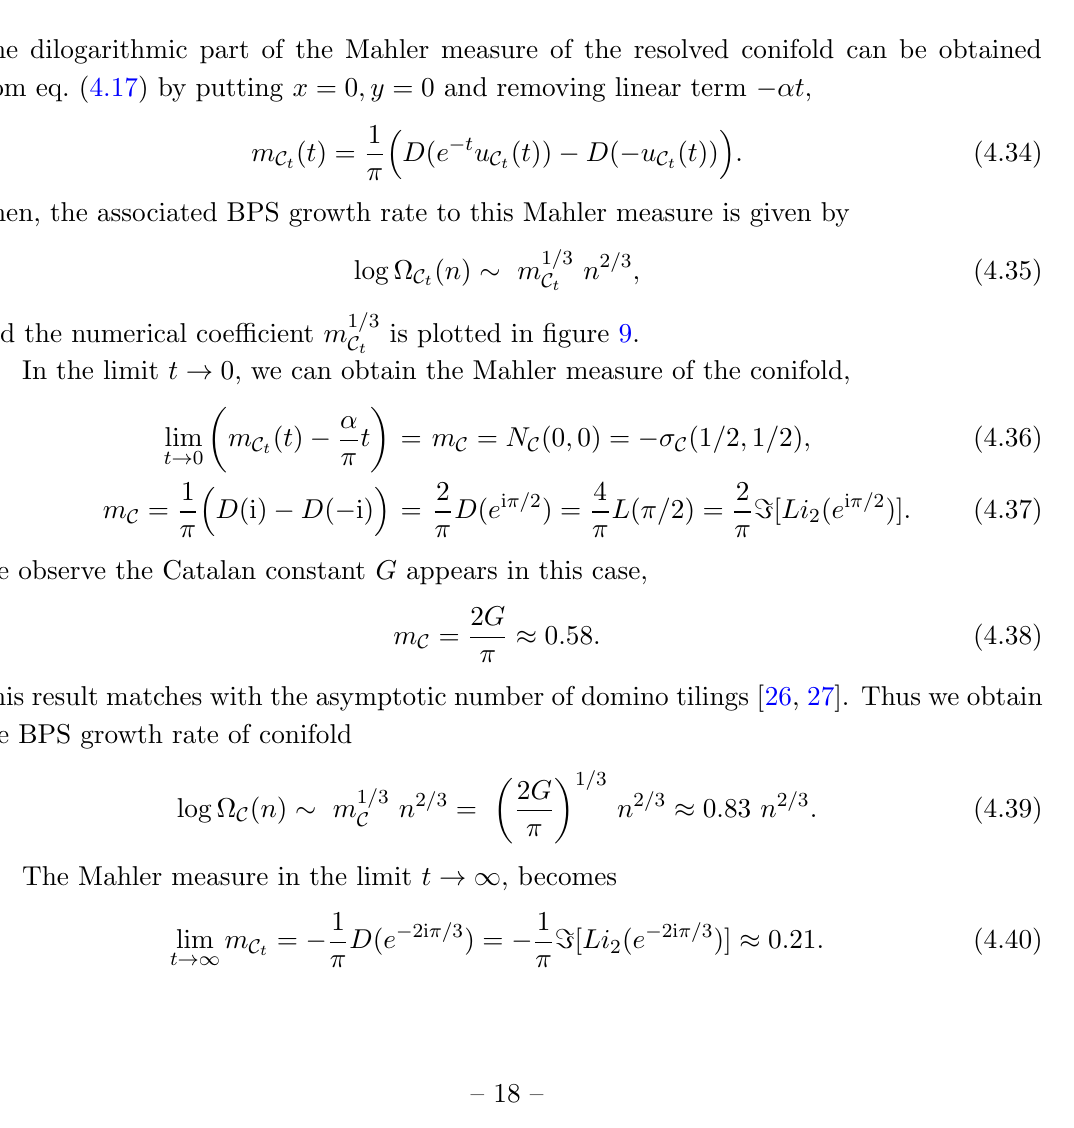
Figure 8 . Minus entropy density of the conifold